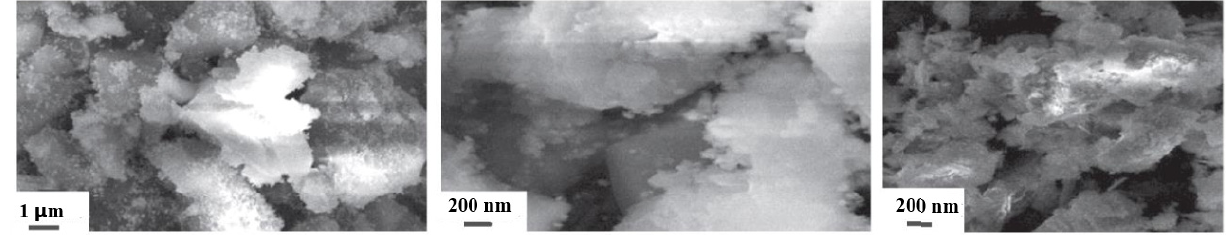
Figure 4. SEM images of the composites of copper trimesinate with 5, 10 and 20% GO, respectively.